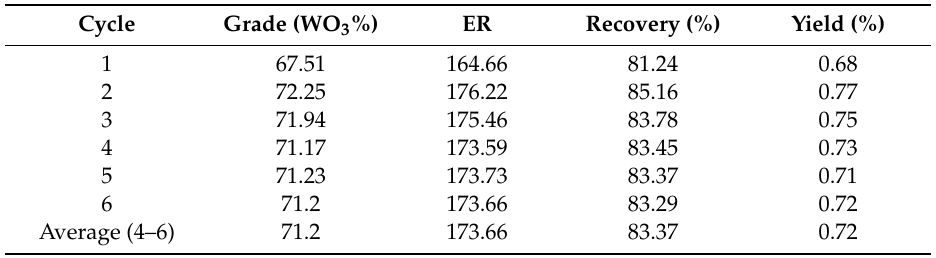
Table 2. Concentrate grade, enrichment ratio (ER), recovery and yield of each cycle product of locked cycle test.